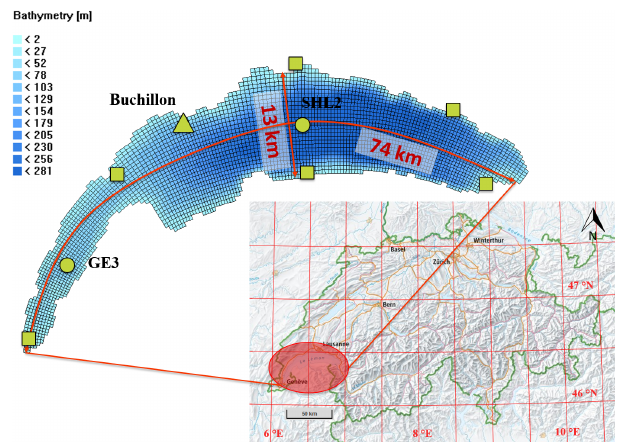
Figure 1. Lake Geneva locations, computational grid, and bathymetry. Circles are in situ measurement sites. The triangle indi- cates the AVHRR validation station. Squares are selected sampling locations used to generate the wind fields of the COSMO-E prod- ucts. Basemap source: Federal Office of Topography ©